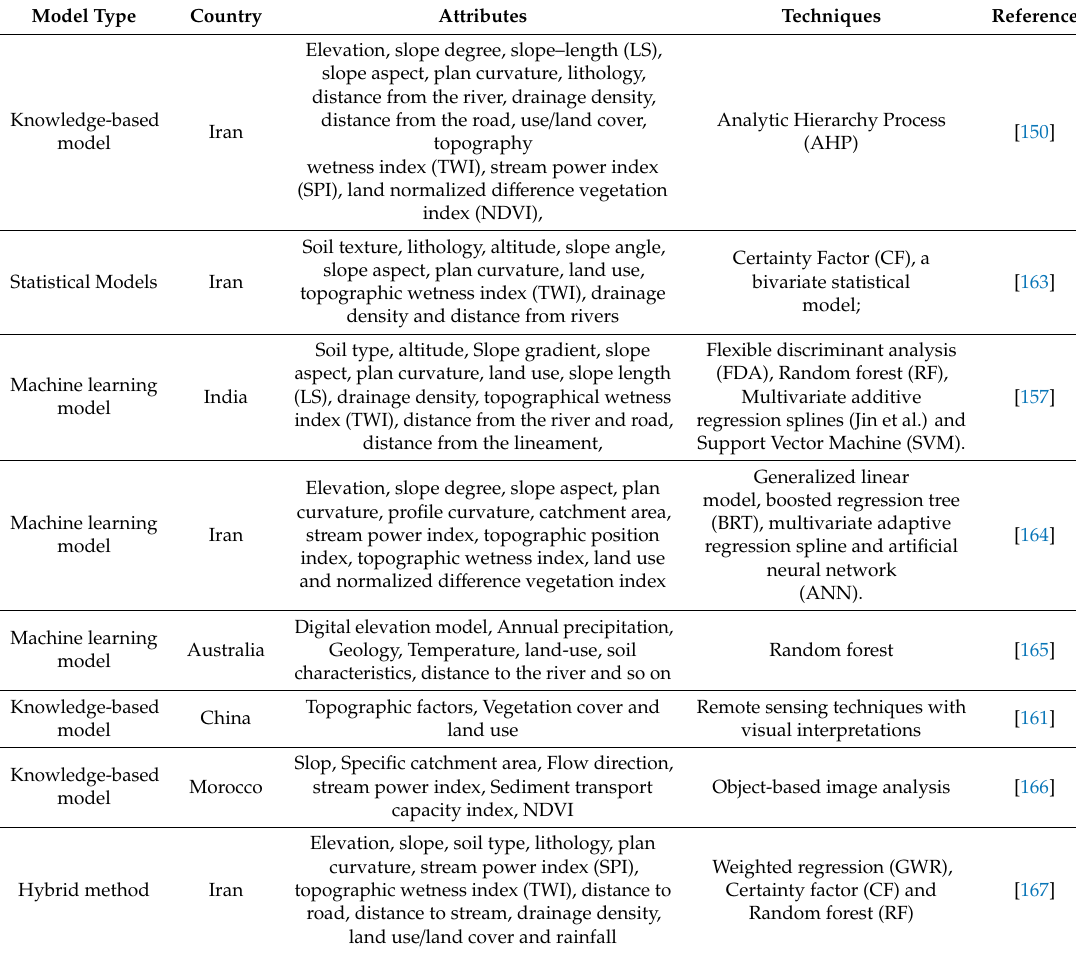
Table 4. Gully erosion assessment and mapping